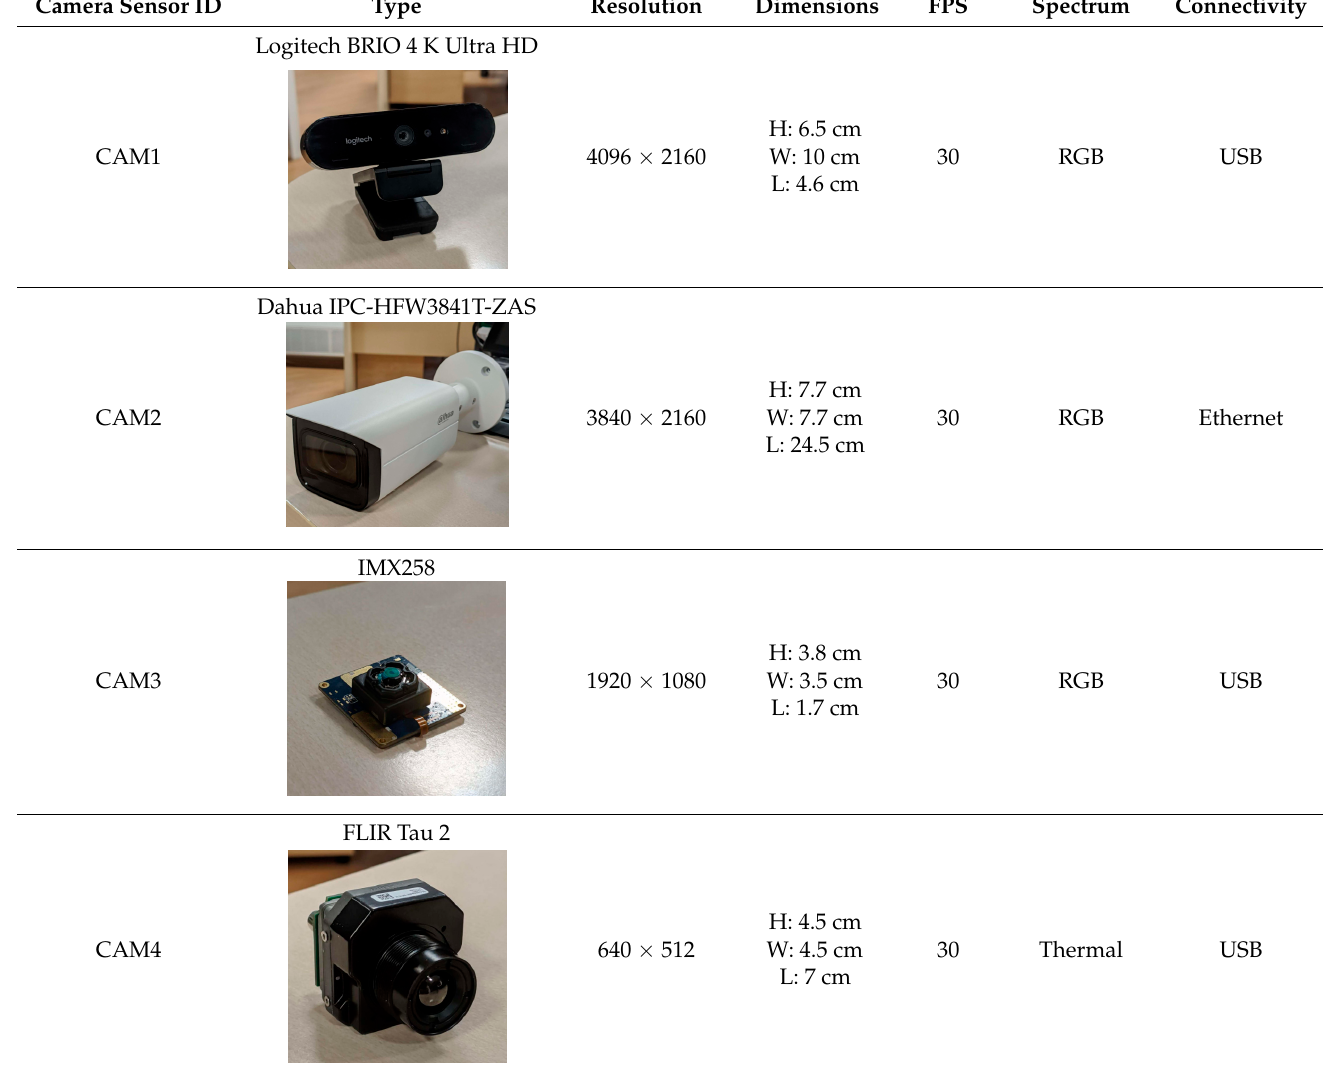
Table 1. Main characteristics of the camera sensors used in this study. Camera Sensor ID